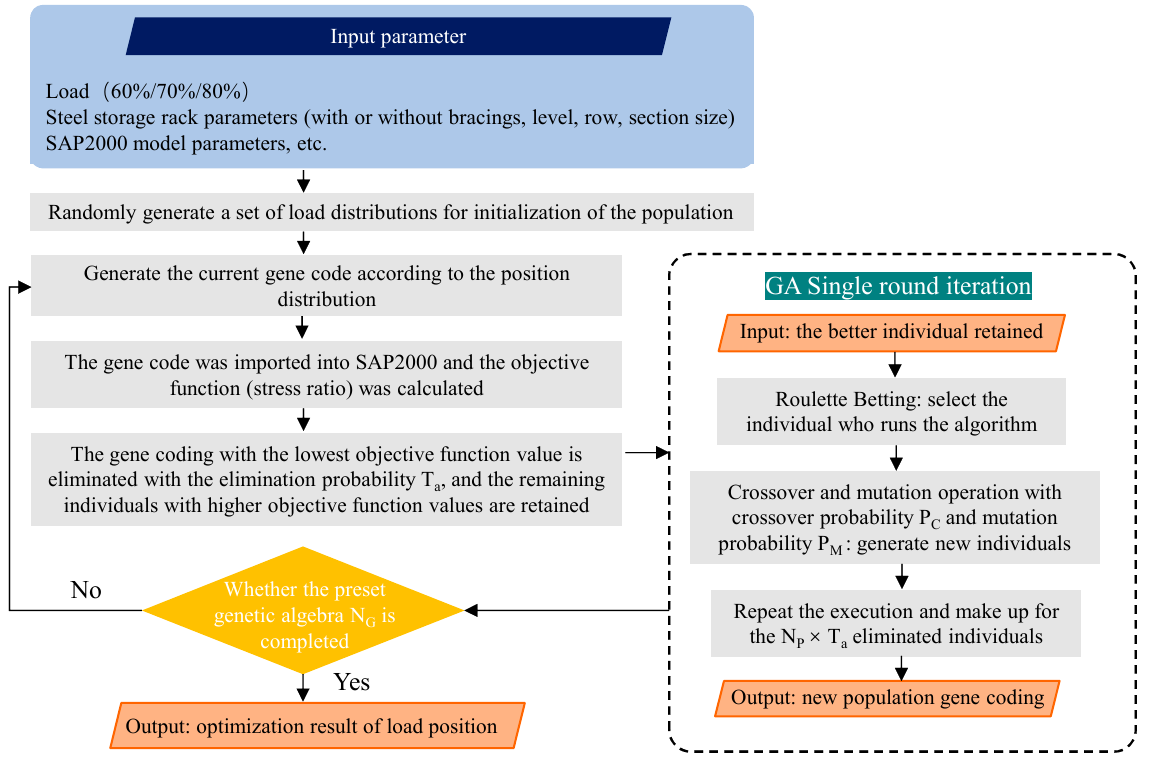
Figure 5. Flowchart of the program for GA. Table 2. Related parameters in GA.